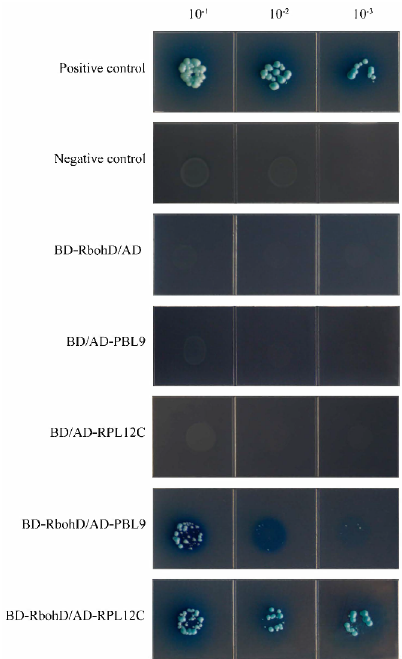
Figure 8. Yeast two-hybrid assays of the interactions of GhRbohD with GhPBL9 and GhRPL12C. Transformants were grown on SD/-Leu/-Trp/-Ade/-His (+ X- α -gal) media. pGBKT7-53/pGADT7- RecT was used as the positive control. pGBKT7-Lam/pGADT7-RecT were used as negative controls.